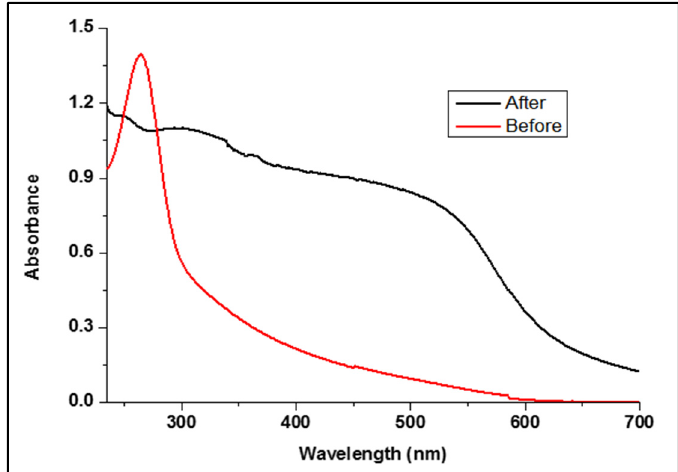
Figure 9. Absorbance of SeNPs before and after treatment.